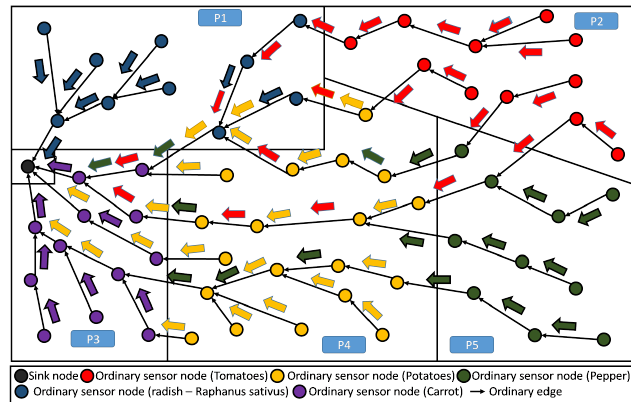
Figure 10. Standard RPL DODAG: high data heterogeneity decreasing the aggregation